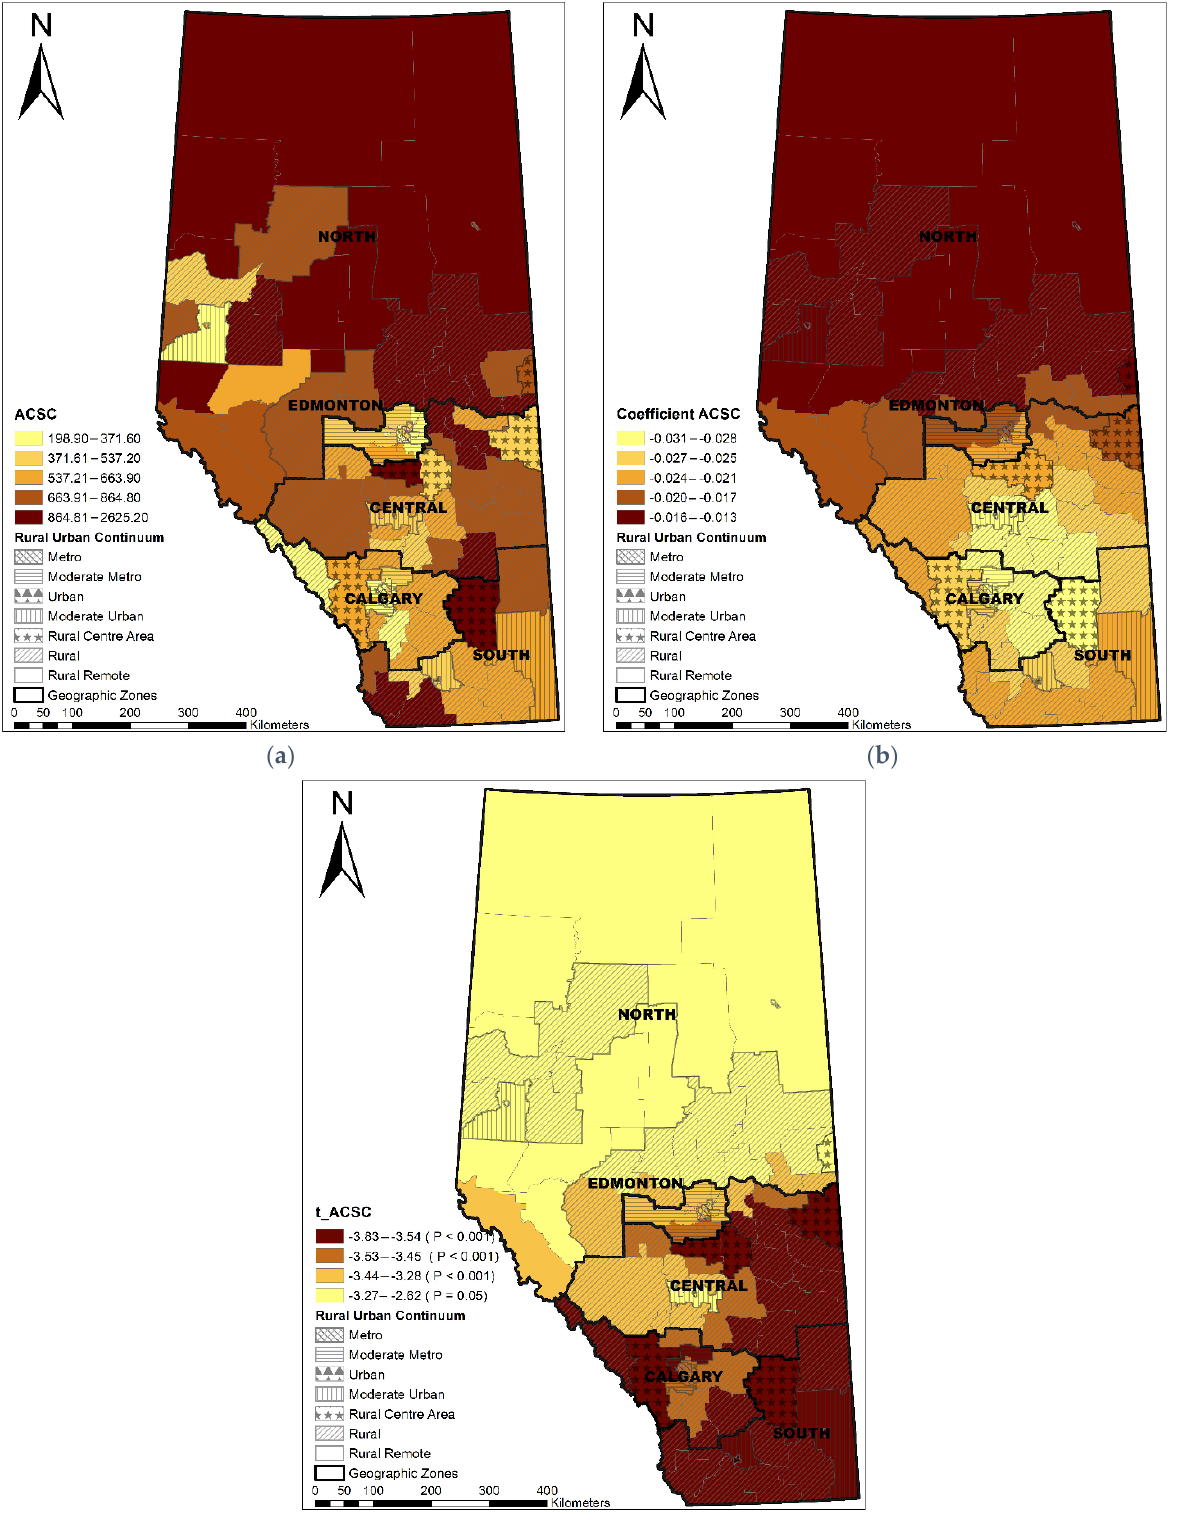
Figure 5. Distribution of ACSC ( a ), coefficient of ACSC ( b ), and significance of coefficient ( c ).